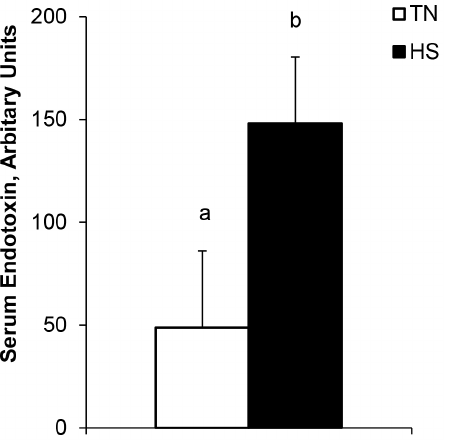
Figure 4. Heat stress conditions (HS; 35 u C) alters expression and localization of TJ proteins compared to pigs reared in thermal neutral conditions (TN; 21 u C) for 24 hours. Supplemen- tal figure in support of Table 2.